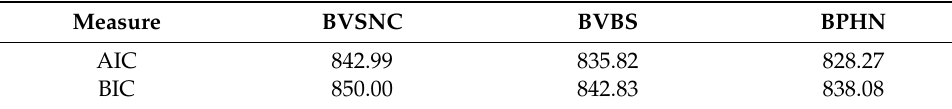
Table 3. AIC and BIC